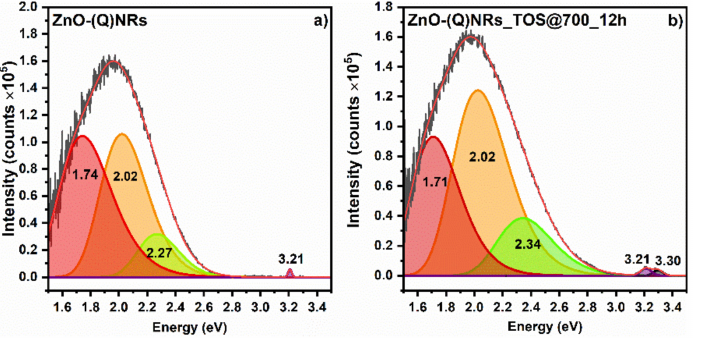
Figure 13. Photoluminescence spectra of as-synthesized ZnO-(Q)NRs ( a ) and after time on stream reaction at 700 ◦ C ( b ). Excitation wavelength: 300 nm.